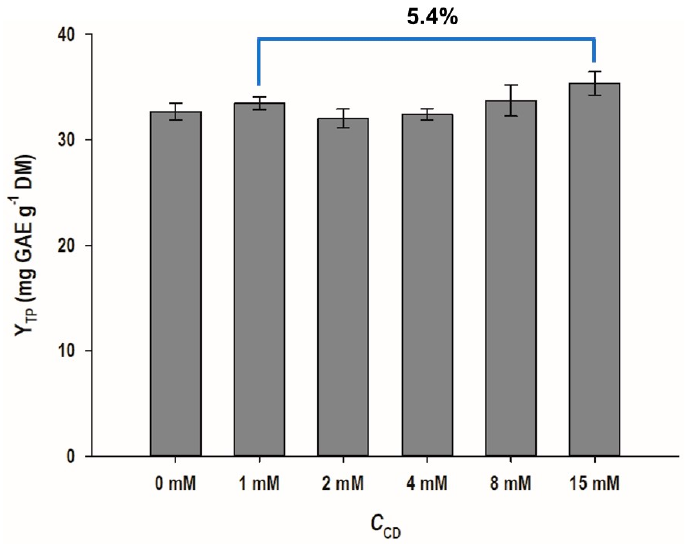
Figure 1. Screening for the effect of β -CD concentration ( C CD ) on the yield of total polyphenols (Y TP ). Extractions were accomplished for 180 min at 40 °C.